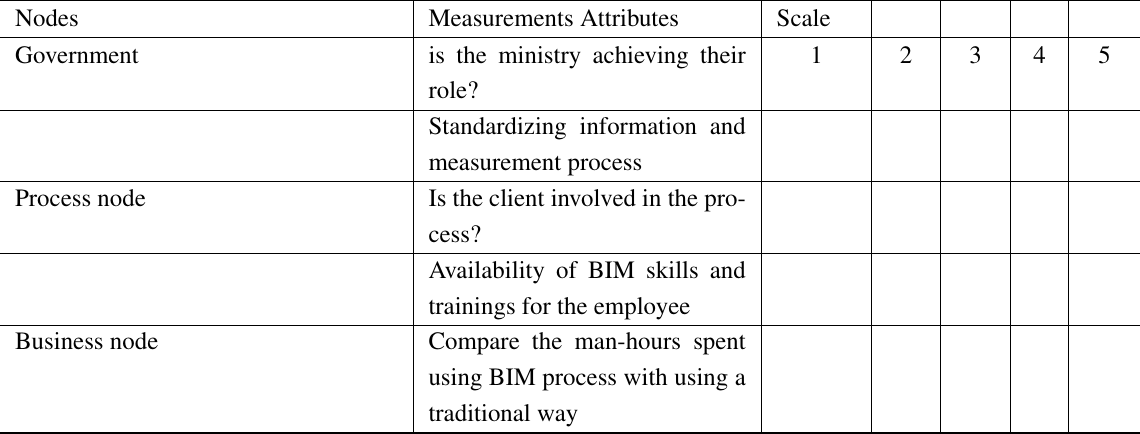
Table 7. Evaluation matrix of BIM framework implementation by the user